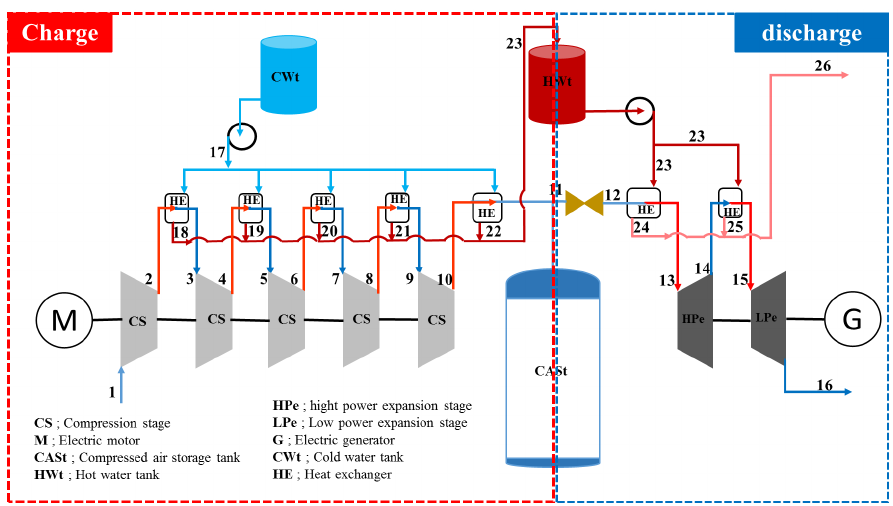
Figure 1. Schematic diagram of the proposed